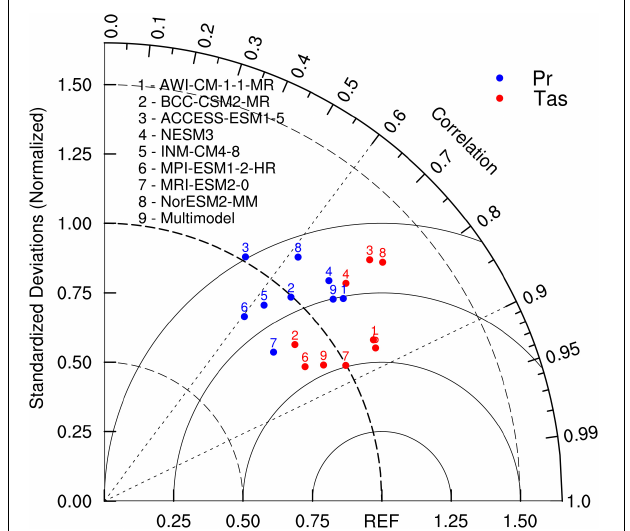
FIGURE 3 | Taylor diagram of annual mean Tas and Pr between the CMIP6 data and reanalysis data in China.